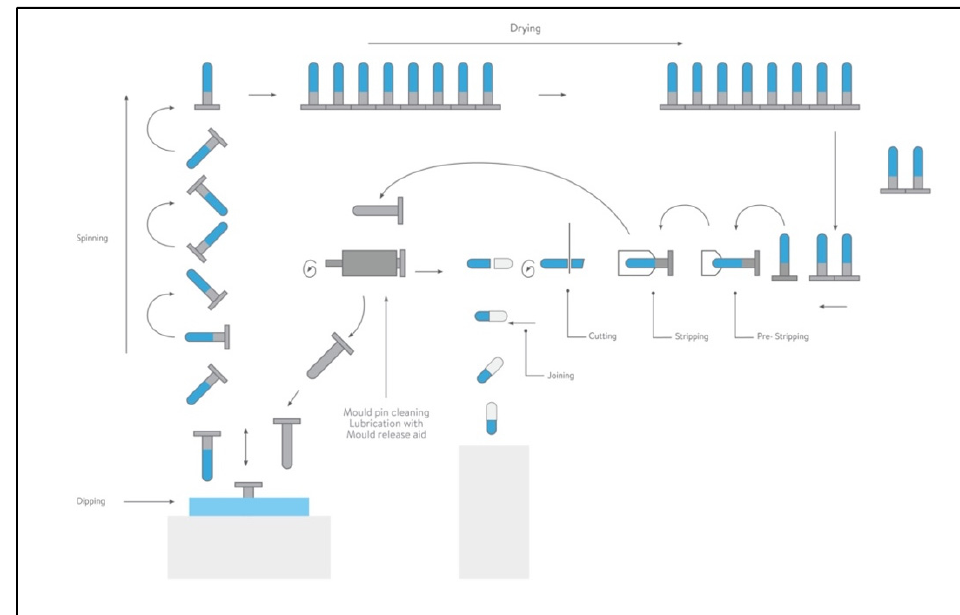
Figure 2. Capsule process production (courtesy supplied by Qualicaps).